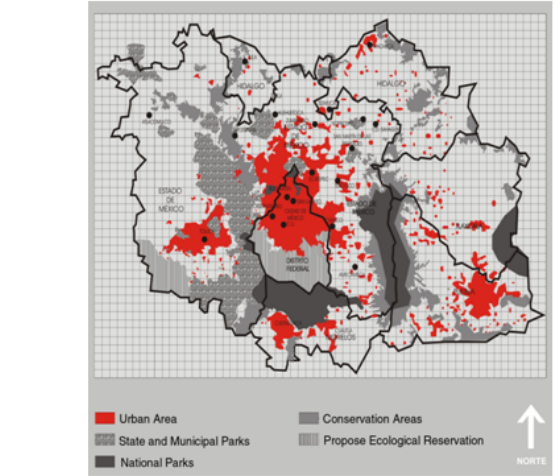
influences (Sect. 9); regional plume from INTEX-B flights over Mexico City and the Gulf (Sect. 10); and health stud- ies (Sect. 11). A summary of key findings is presented in Sect. 12; while some directions for future research are pre- sented in Sect. 13. A list of acronyms is provided in Ap- pendix